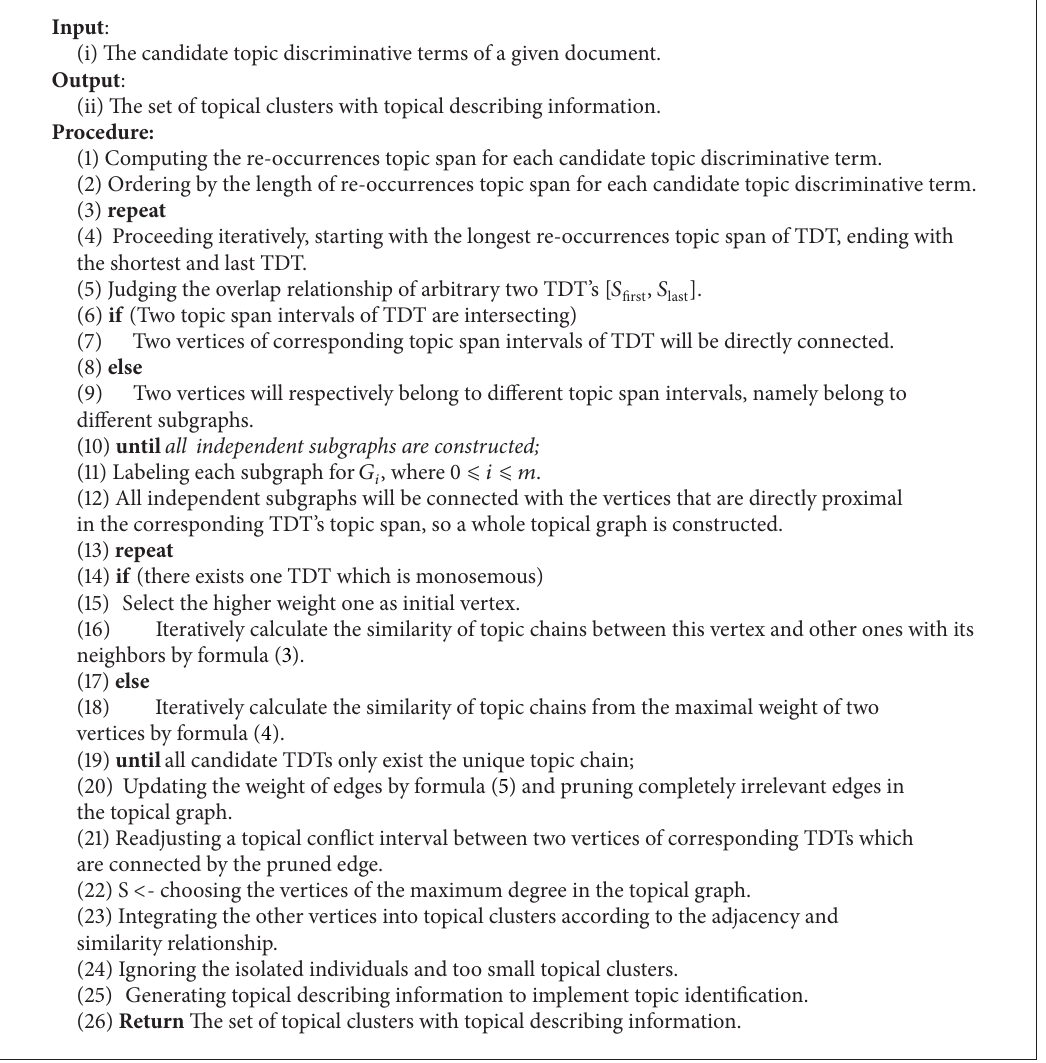
Algorithm 1: Leveraging Topic Discriminative Term for Topic